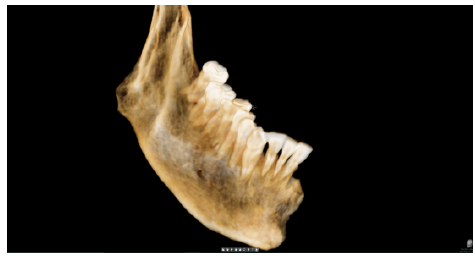
Figure 4. Shengavit: excavations of the 4th tomb